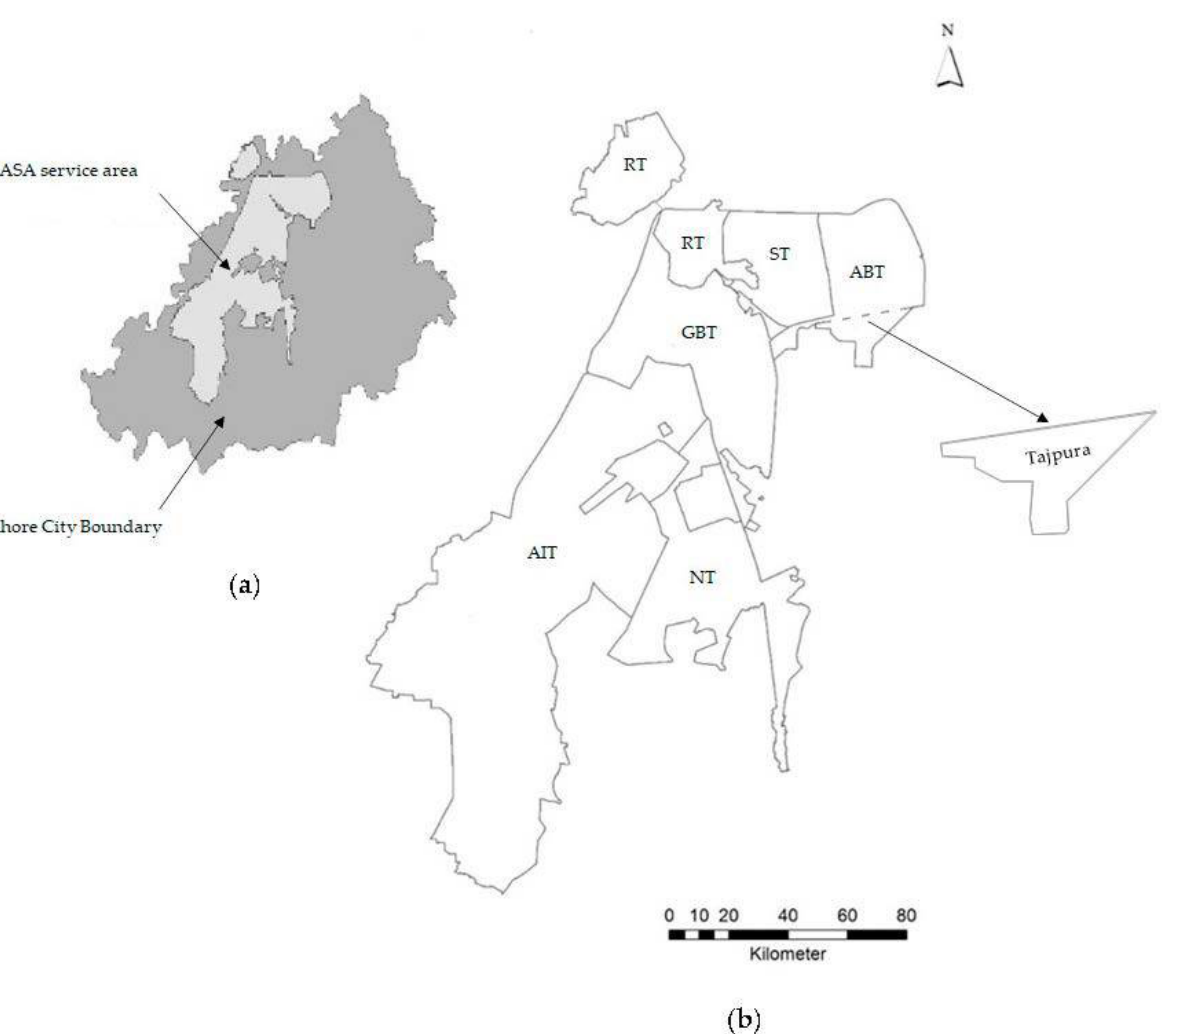
Figure 1. Study area: ( a ) WASA service area in Lahore City; and ( b ) townships in WASA service area.